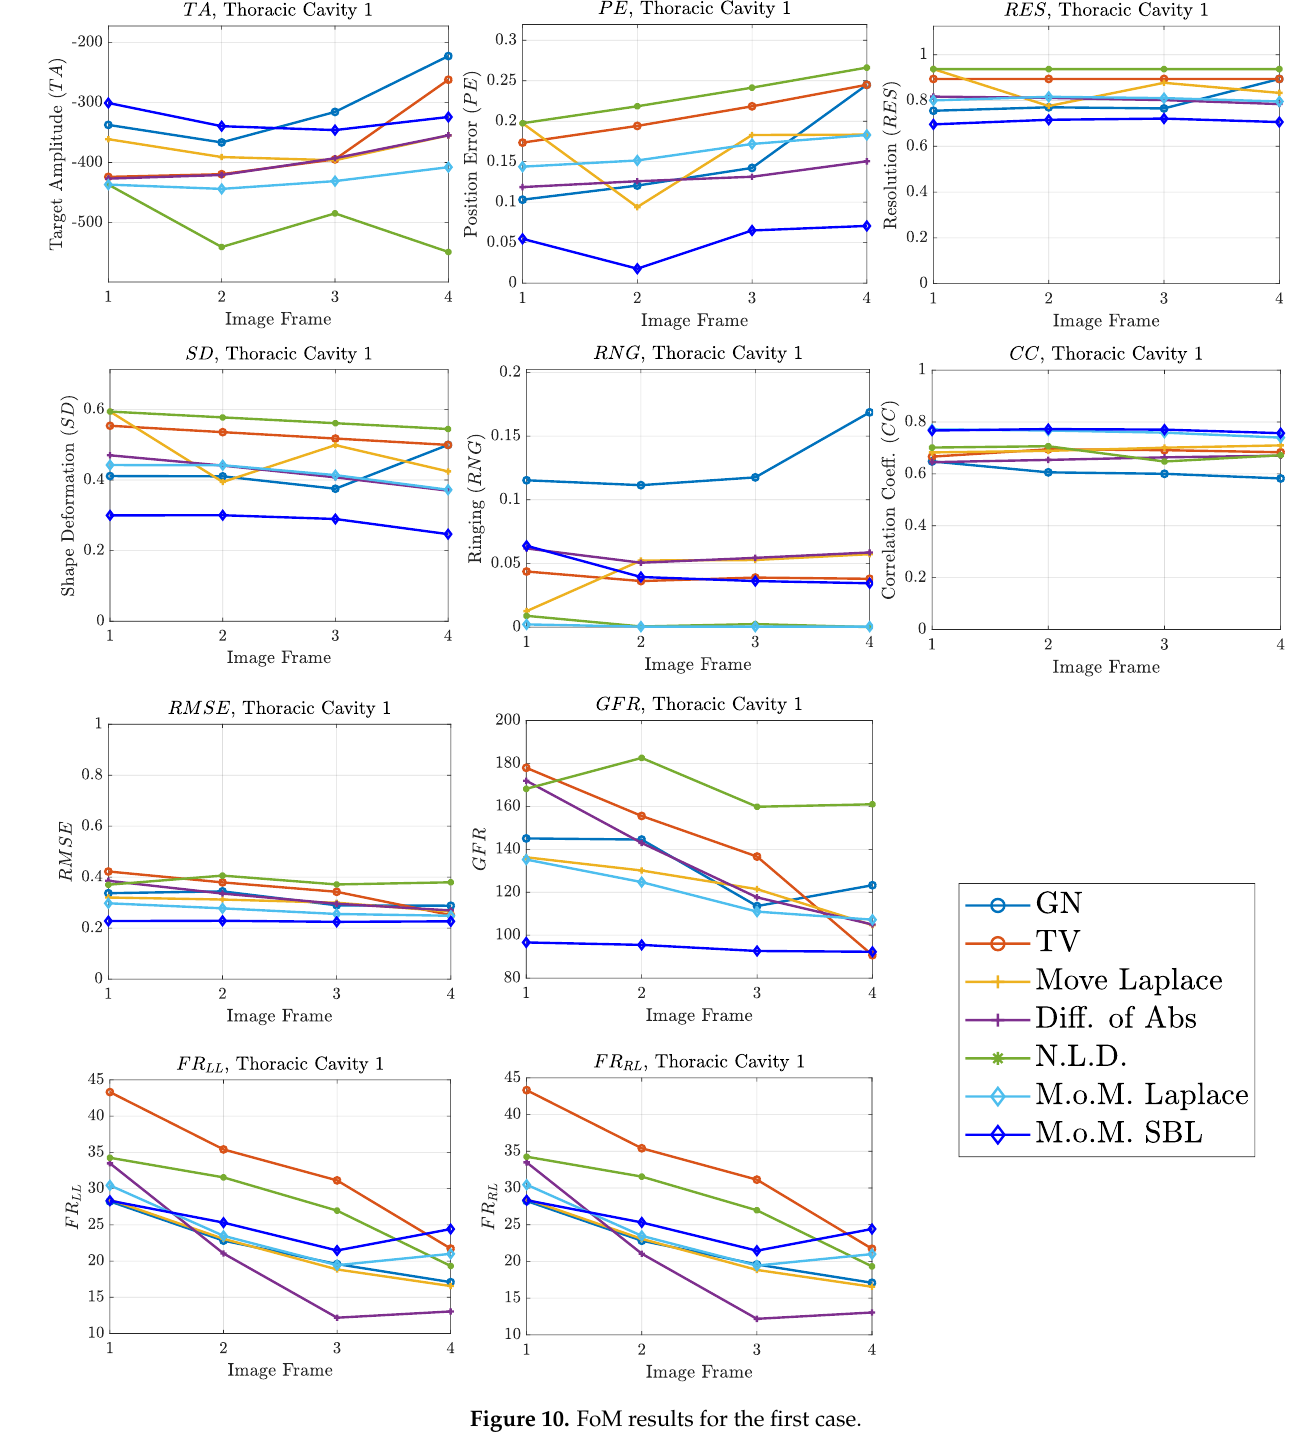
Figure 10. FoM results for the first